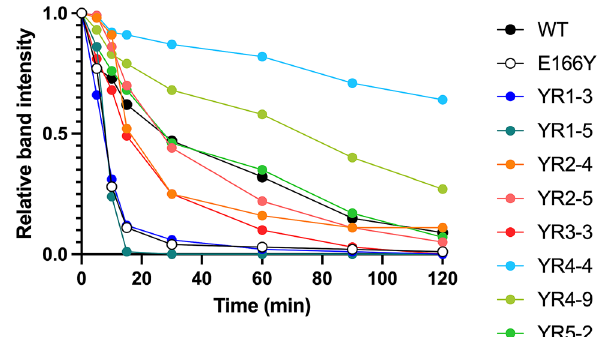
Figure 6. Susceptibility of TEM variants to trypsin digestion. Purified TEM variants (0.5 mg/ml) were incubated with 0.01 mg/ml trypsin in 20 mM Tris–HCl pH 7.5 and 50 mM NaCl at 25 °C. Aliquots from different time points were analyzed by SDS-PAGE. The intensity of full-length protein bands was analyzed by ImageJ 25